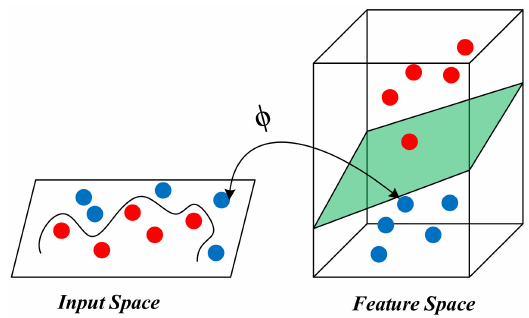
Figure 3. The model of support vector machine